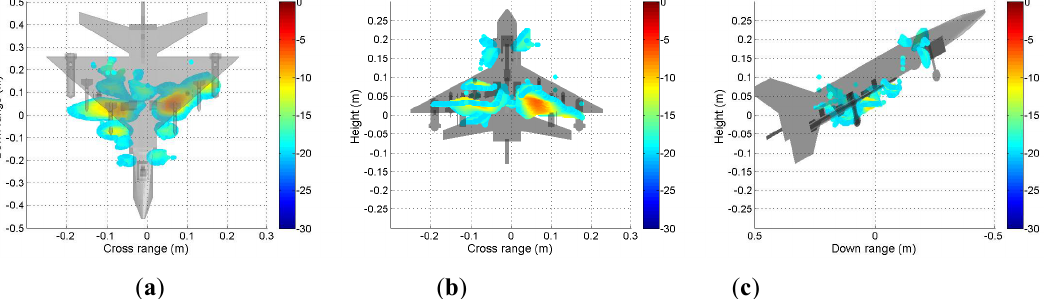
Figure 12. Tomography result in VH polarization. Three views of the airplane model are shown: ( a ) top view; ( b ) bottom view; ( c ) side view.